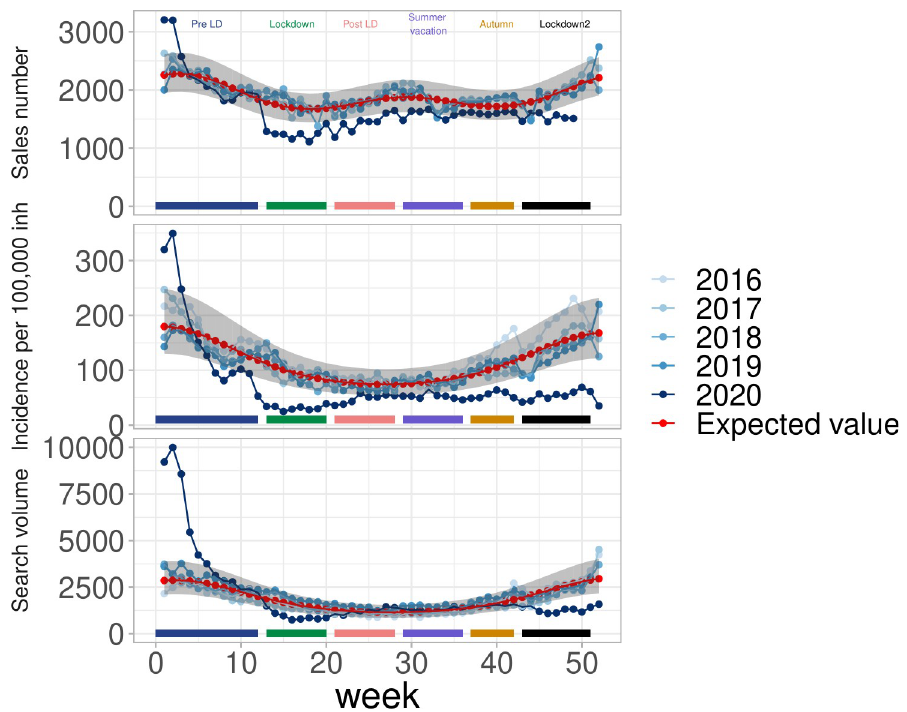
Fig 1. Acute diarrhea in France during the COVID-19 pandemic. (top) drug sales, (middle) Incidence in general practice and (bottom) search query volume.